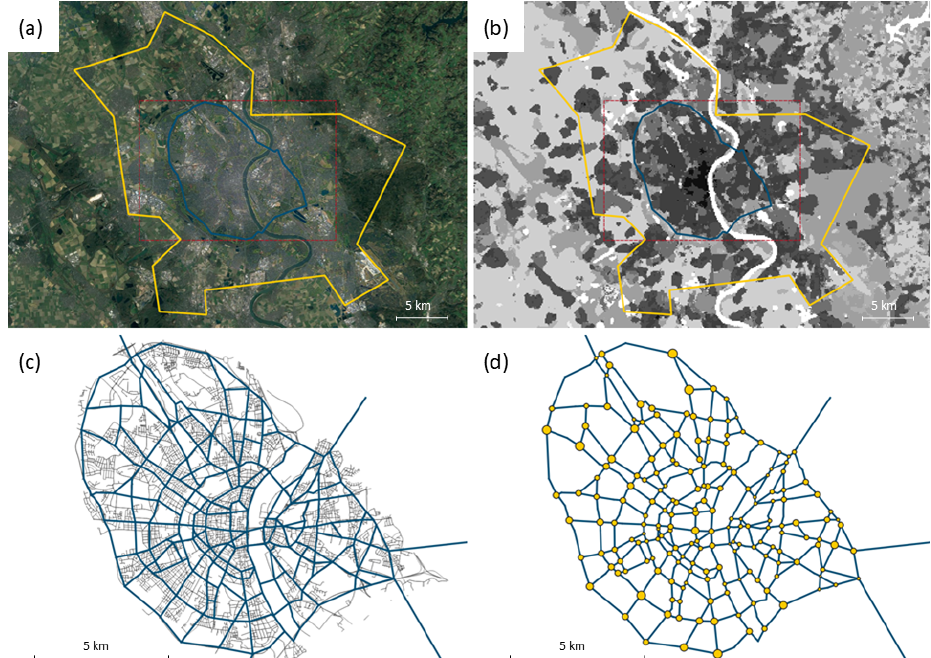
Figure 2. ( a ) Satellite image (Google Earth, 2021) and ( b ) local climate zones of Cologne, Germany [15]. The yellow polygon marks the administrative boundary, and the blue one, the inner city, which is investigated in this paper. ( c ) Streets from OpenStreetMap with the possible network topology are represented by blue edges. ( d ) The possible network topology with sizes of the nodes (yellow points) represent the water demand disaggregated to the